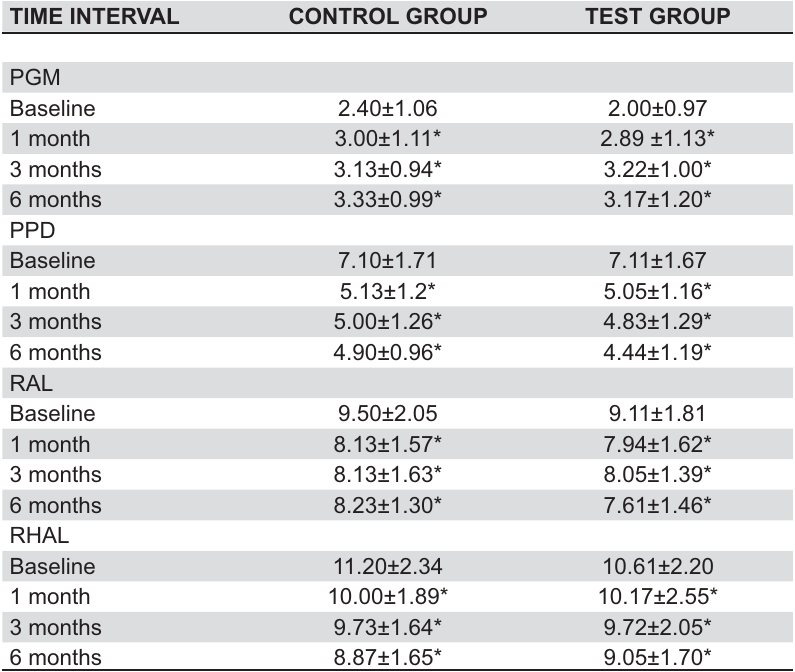
Table 3- Mean ± standard deviation of position of the gengival margin (PGM), probing pocket depth (PPD), relative attachment margin (RAL) and relative horizontal attachment level (RHAL) (mm) at different time intervals for control and test groups